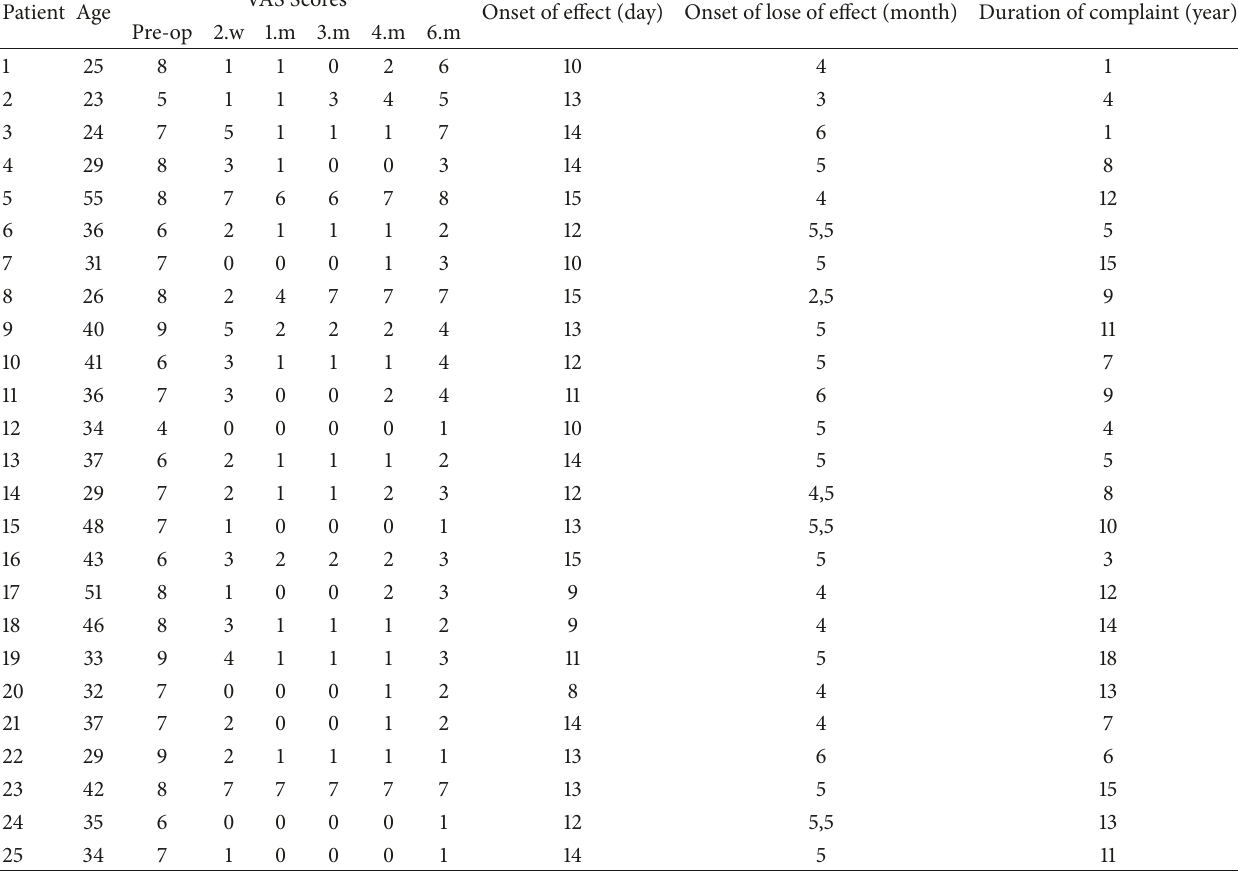
Table 1: The demographic data, pain scores, the time of the onset of the effect, the time of the onset of the loss of effect, and the duration of the complaint of all the patients.